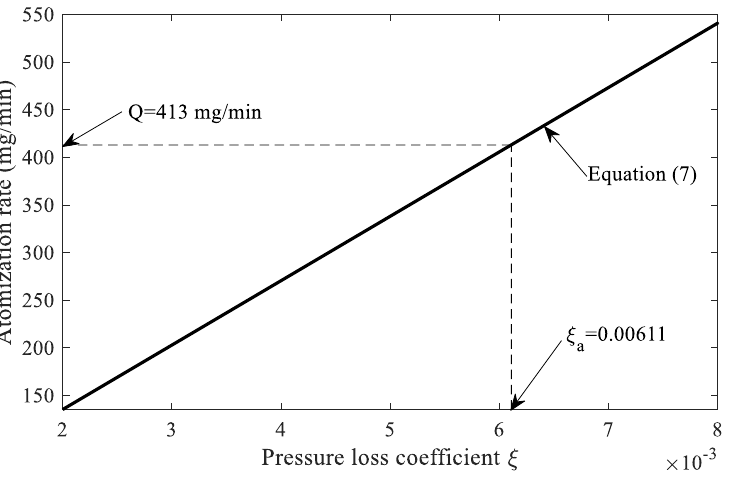
Figure 16. Approximation of an effective pressure loss coefficient using the experimental results. Using the found loss coefficient ( ξ a ) , an approximation of the atomization rate as a function of the voltage can be obtained using Equation (7). The variations of the volume (cid:16) (cid:17) ∆ V ef f , ∆ V S were calculated for every displacement distribution of the thin plate as D given by the FEM at the resonance frequency of 110 kHz. For these calculations, the loss coefficient was kept